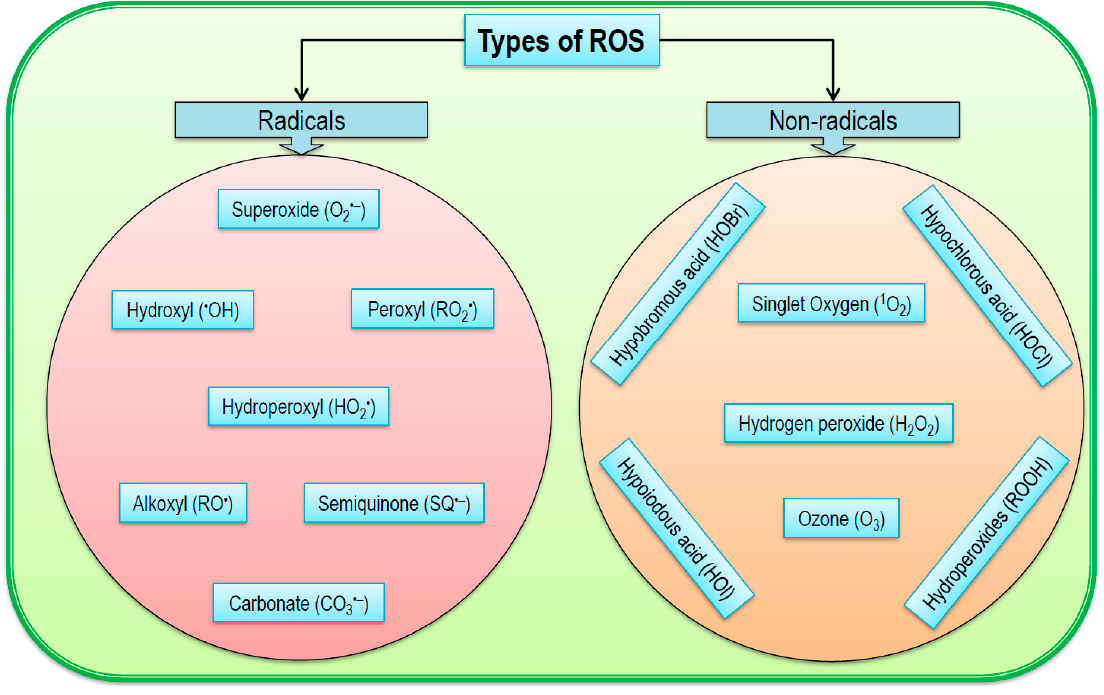
Figure 2. Types of reactive oxygen species in plants.